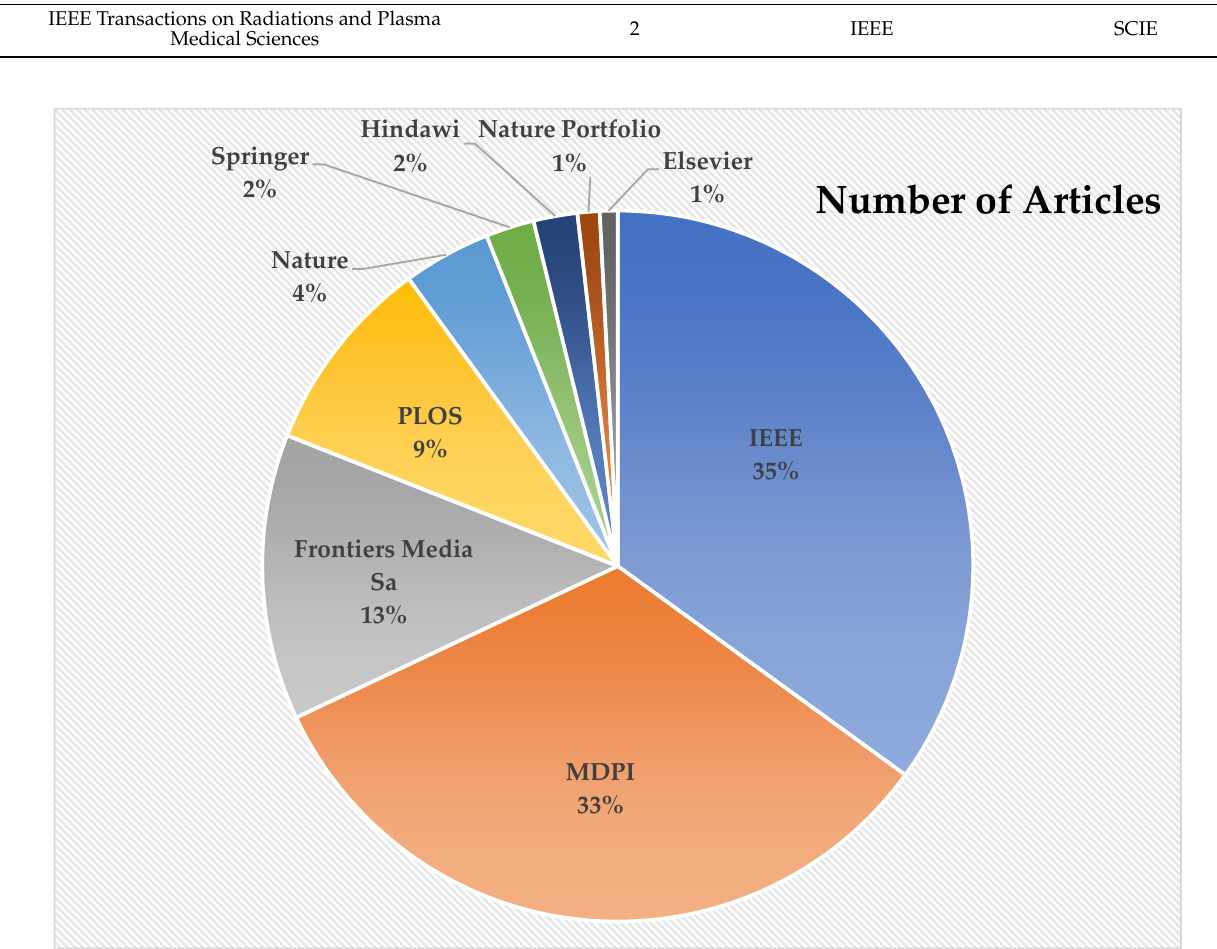
Figure 4. Distribution of articles based on publishers.